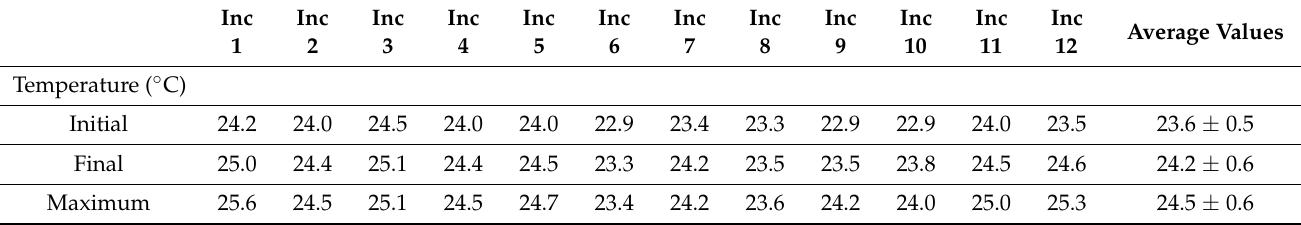
Table 3. Recorded values for Temperature, Relative Humidity and